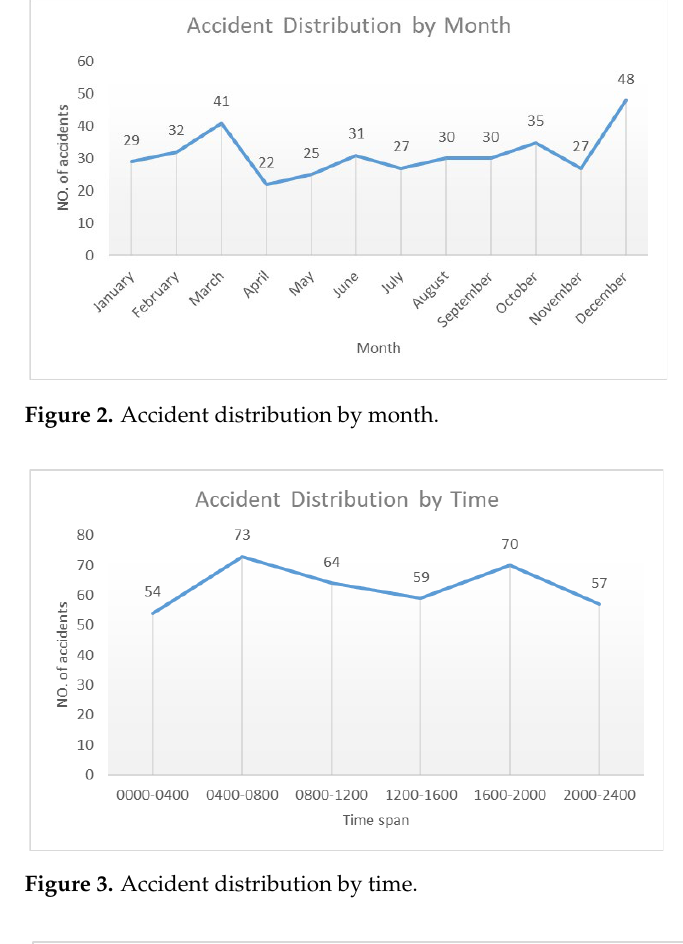
Figure 3. Accident distribution by time.